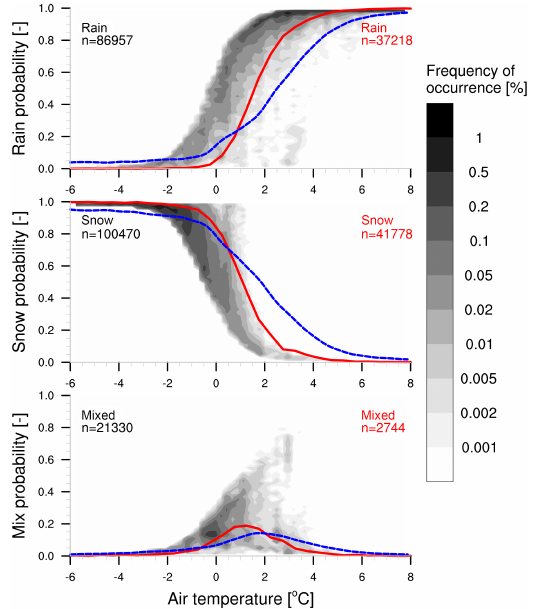
Figure 12. PP probability shown using the new 3P2D method with two individual PP distributions ( T _rH_ D 99 ) as frequency of occur- rence (%) in gray shades against air temperature according to PP reference data that separates rain, snow, and mixed phase in Ocean- RAIN ALL for more than 4 years of RV Polarstern data. Solid red lines represent the mean PP fraction from observations in the Swiss Alps (1991–2010) from Froidurot et al. (2014); dashed blue lines show mean PP fraction for oceanic ship data (DS464.0; 1977–2007) from Dai